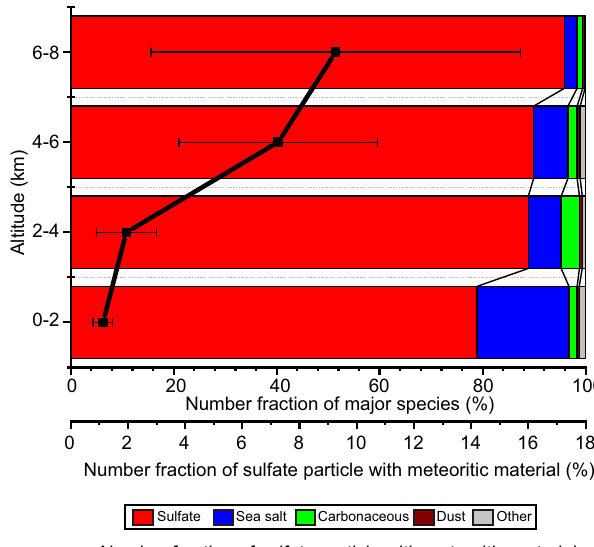
Fig. 2 Fractions of major aerosol species and sulfate particles with meteoritic materials along with sampling altitudes. Errors are shown in a 90% con fi dence interval. The numbers of samples analyzed by TEM were 63, 44, 22, and 6 for altitude ranges of 0 – 2, 2 – 4, 4 – 6, and 6 – 8 km,